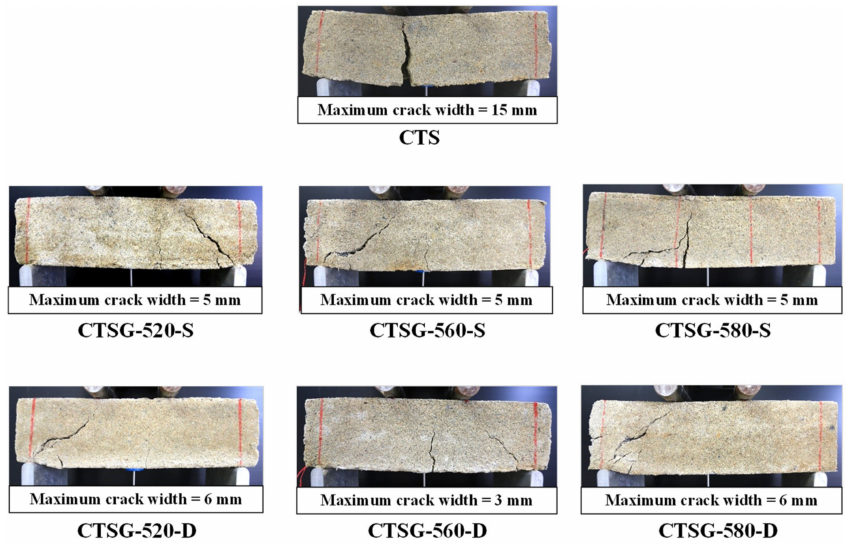
Figure 11. Crack